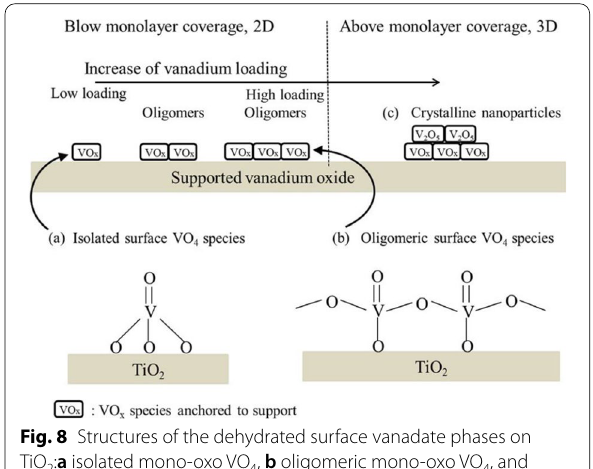
Fig. 9 Structures of supported a monomeric and b oligomeric VOx units. c Crystal structure of orthorhombic phase V 2 O 5 (Pmnm, No.59).